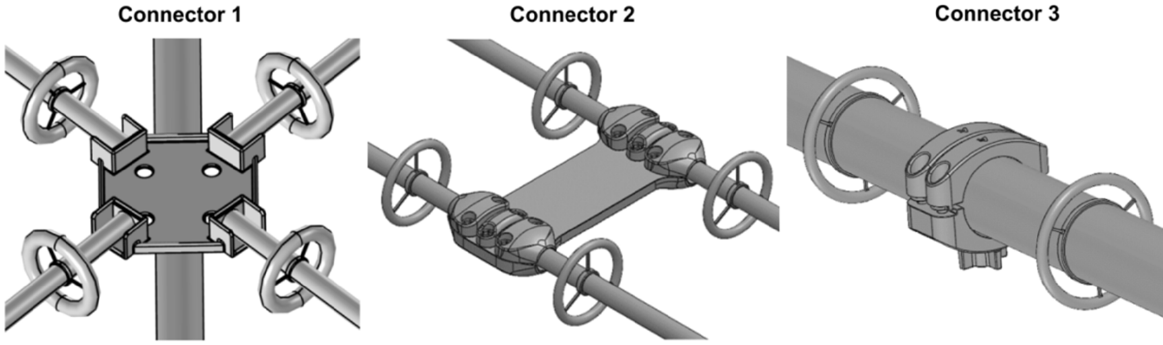
Figure 3. Connector with rings installed around the conductors.